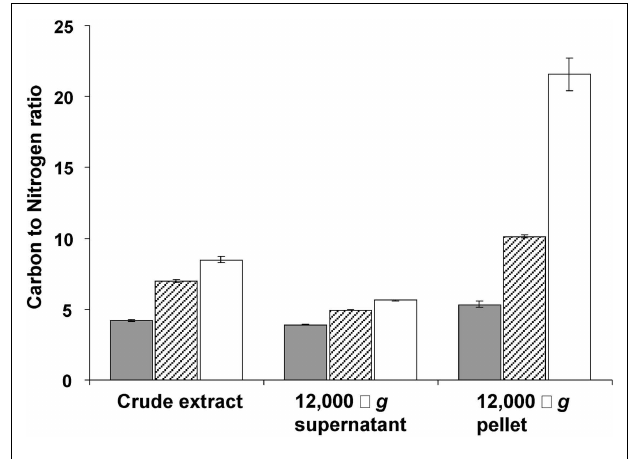
FIGURE 4 | Carbon to nitrogen ratio (mg/mg) in the crude extract, 12,000 × g supernatant and 12,000 × g pellet prepared from cells harvested in the exponential phase (gray bars), at the end of transition phase I (dashed bars) and II (white bars). Error bars represent SEM ( n = 3).